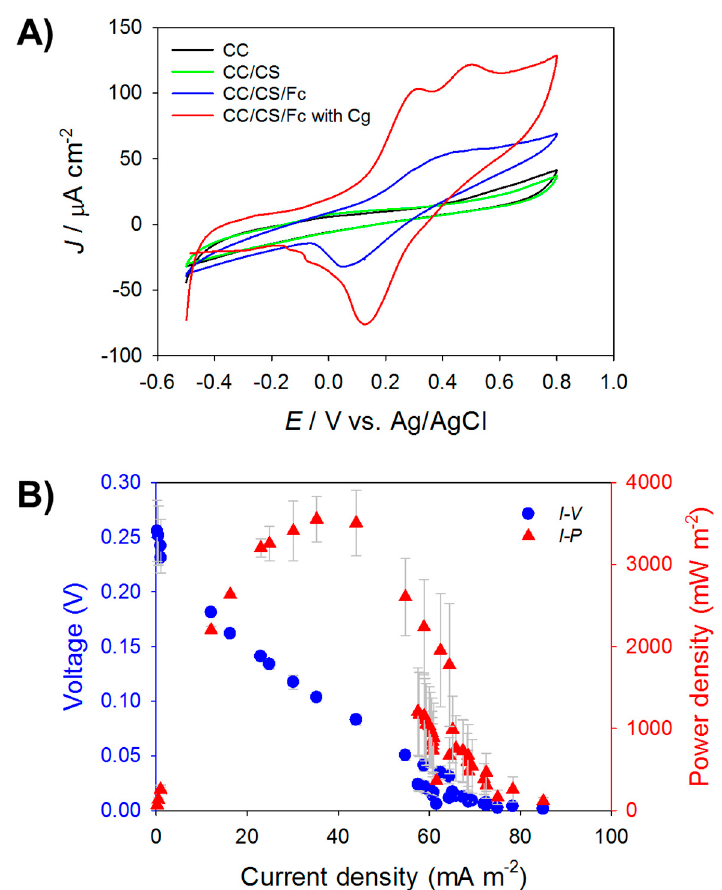
Figure 6. ( A ) Cyclic voltammograms of redox-hydrogel-modified electrode. CC, bare carbon cloth electrode; CC / CS, chitosan hydrogel modified electrode; CC / CS / Fc, ferrocene-branched chitosan redox-hydrogel modified electrodes, and Cg, C. glutamicum . Scan rate, 10 mV s − 1 . ( B ) Voltage and power density measurements as function of applied current for device. Circle symbols (blue), current-voltage (I-V) curve. Triangle symbols, current-power density (I-P) curve.